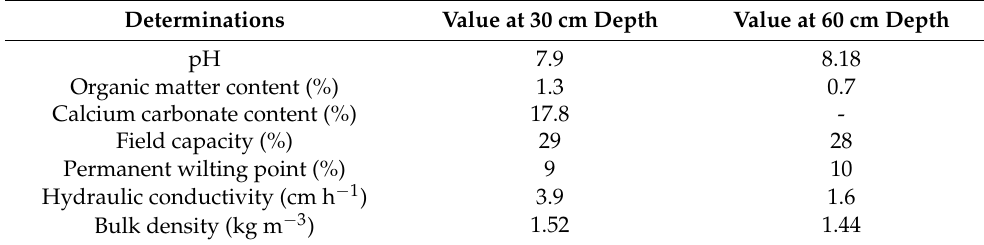
Table 1. Soil analysis results before the tests start. Showed values were the mean of the